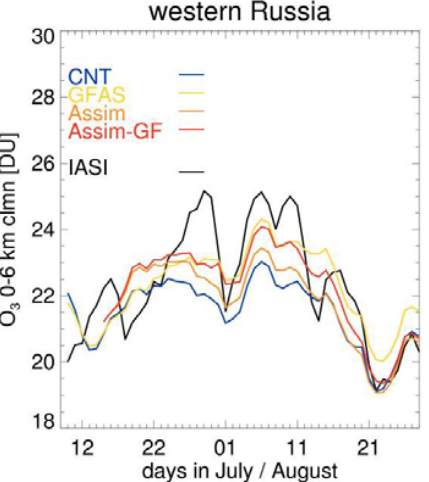
Fig. 10. Time series of modeled tropospheric O 3 columns (hind- Figure 10. Time series of modeled tropospheric O 3 columns (hindcast D+0) with averaging 2 cast D+0) with averaging kernel against IASI O 3 columns (0–6km). Data are smoothed over a 3-day time window to filter out variations kernel against IASI O 3 columns (0-6km). Data are smoothed over a 3-day time window to 3 in spatial coverage. filter out variations in spatial coverage. 4